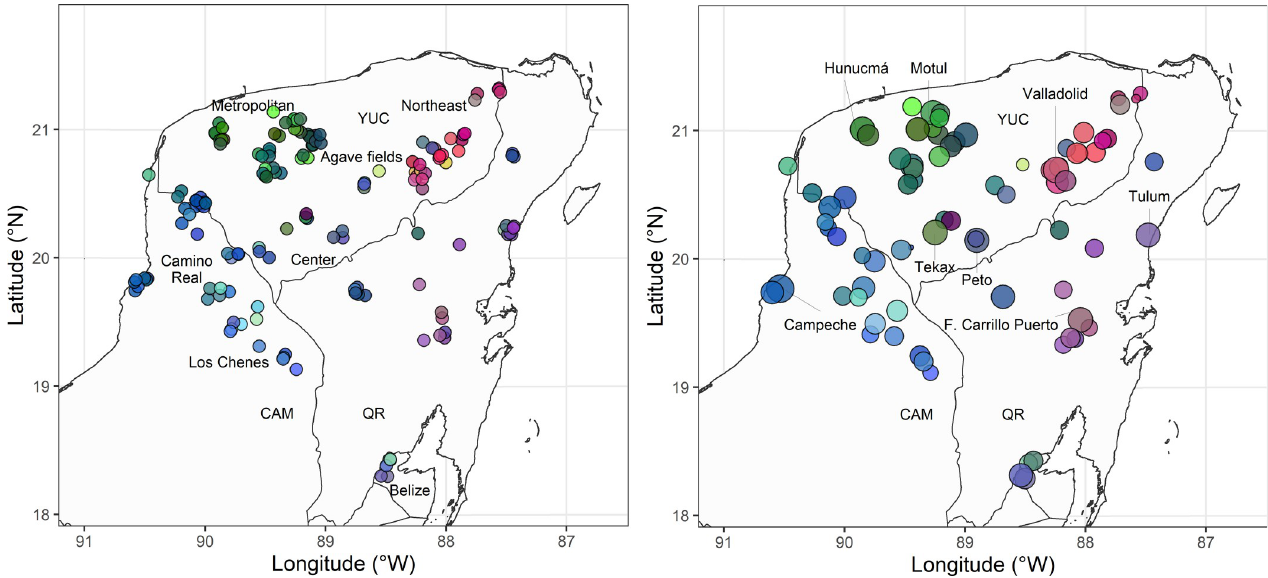
Fig 7. Estimates of multidimensional scaling mapped onto RGB colors. (A) Dots representing individuals. (B) dimensions resulting from multi-dimensional scaling aggregated per location; dot size: Logarithmized population size.